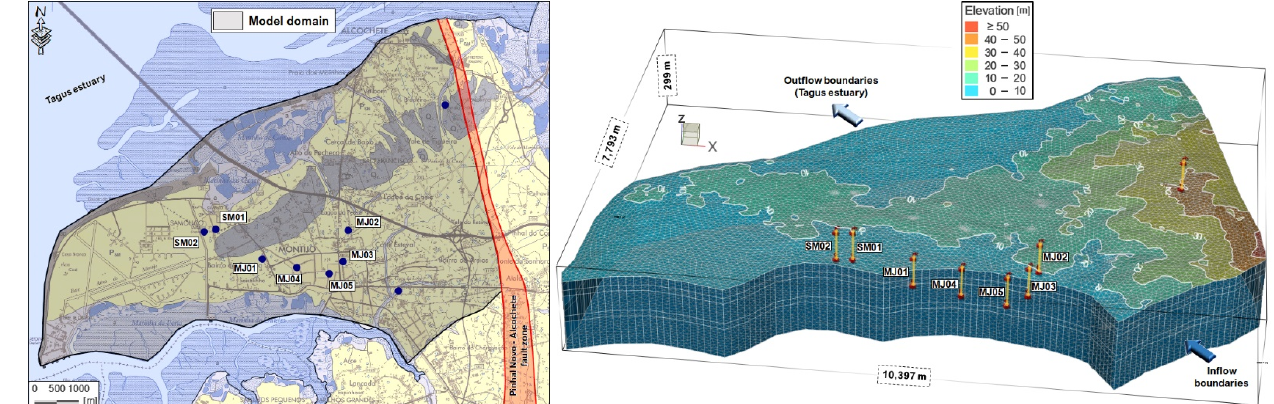
Figure 6. Schematic representation of the model domain in two and three dimensions.